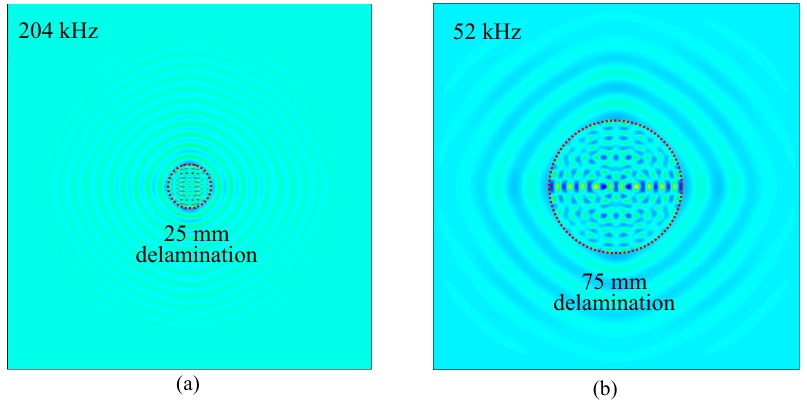
Figure 15. FEM-measured operational vibration shape comparison of the cross-ply composite plate between pristine area and 50 mm delamination at 28 kHz: ( a ) pristine area; ( b ) 50 mm delamination.